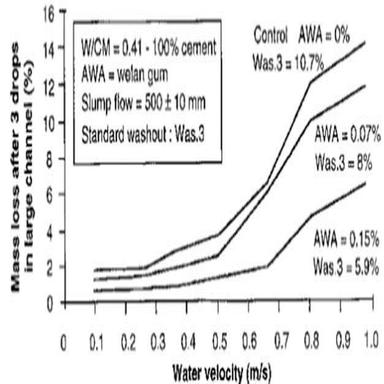
Effect of welan gum content and water velocity on washout mass loss. Reproduced from with permission.